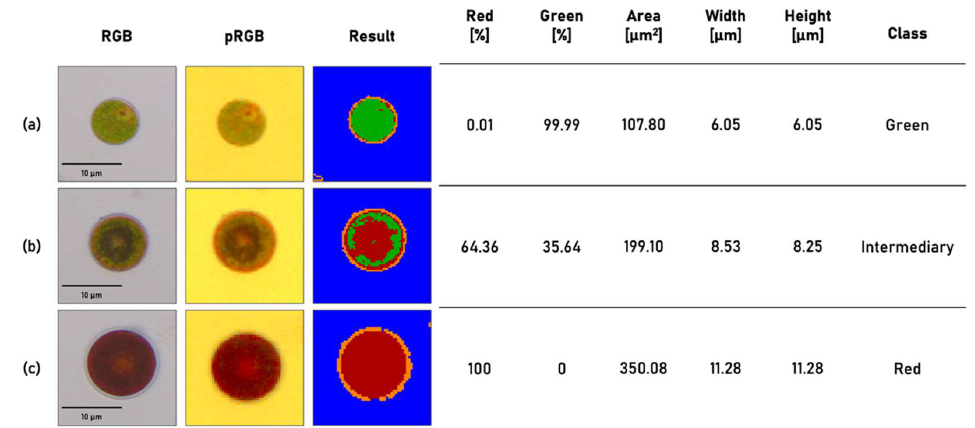
Figure 5. Results of multispectral data processing and spectral modeling. Microscope RGB image from reference camera (left). Processed pseudo RGB image from snapshot-mosaic camera (middle) Result image after multispectral classification ( a ) Green reference cell ( b ) Intermediary cell ( c ) Red reference cell.